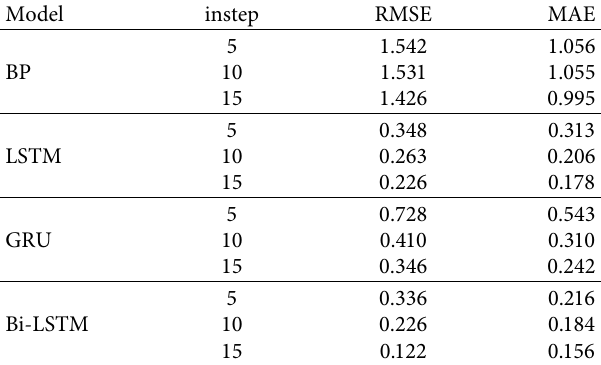
Table 9: h × h prediction performance in test 100 100